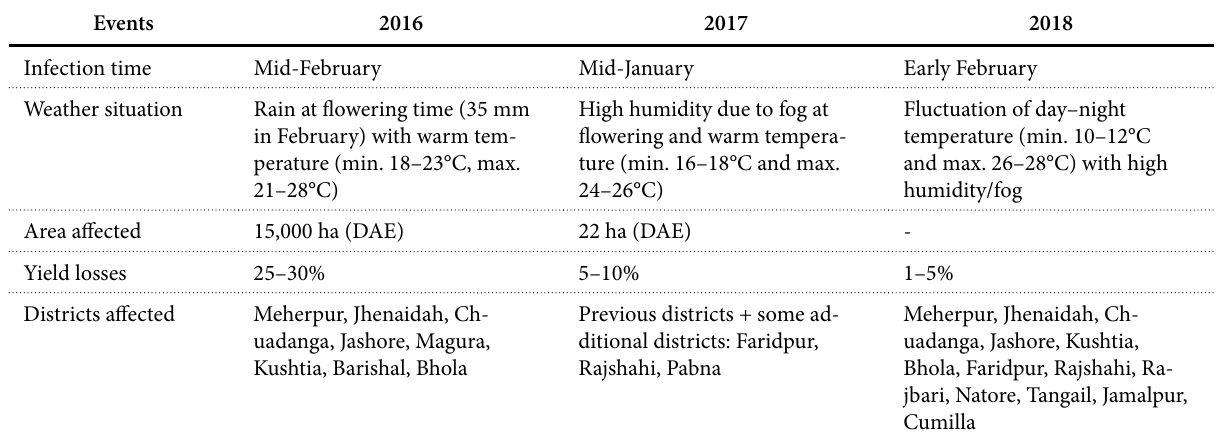
Tab. 2 Comparative status of wheat blast incidence in Bangladesh in the 2015–2016, 2016–2017, and 2017–2018 wheat seasons. Adapted from